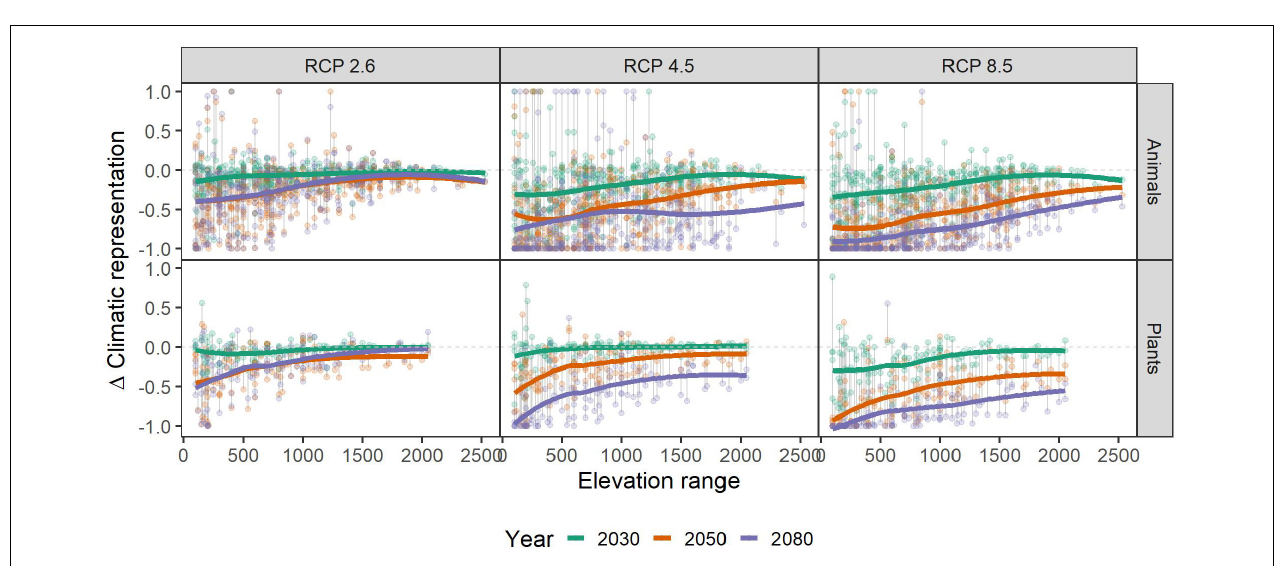
FIGURE 4 | Relationship of mean elevation (meters) of the species’ assumed area of occupancy and their respective gains and losses of representation in the future under climate change scenarios RCP 2.6, RCP 4.5, and RCP 8.5. Colored, bold lines represent splines within each time-step (colors) and scenario (panels) for overview. Gray vertical lines connect data points belonging to one species. A value of -1 means complete loss of representation, and a value of 1 means a doubling of representation. Please note that some species had a relative change > 1, and that for overview, we set those to 1. See Supplementary Table 1 for details.